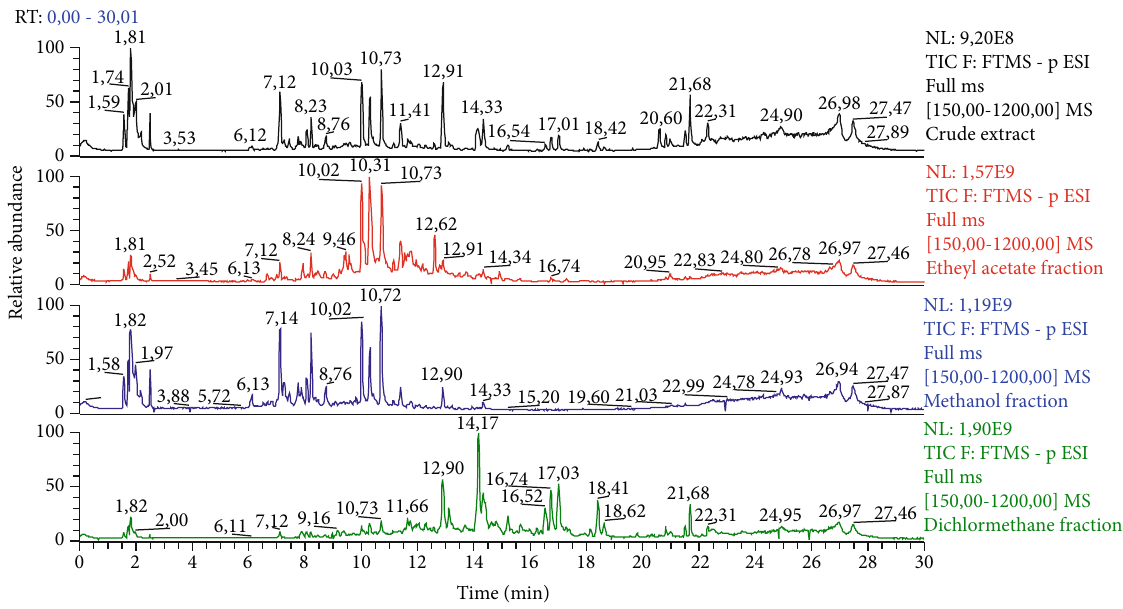
Figure 1: High-resolution electrospray ionization mass spectrometry (HRESIMS) total-ion chromatograms in the negative ion mode of crude extract and ethyl acetate, methanol and dichloromethane fractions. The compounds 3,4-diCQA (1), 3,5-diCQA (2), and 4,5-diCQA (3) possess retention time of 10.0, 10.31, and 10.73min, sample to 60 μ g protein/sample for determining protein phosphorylation.